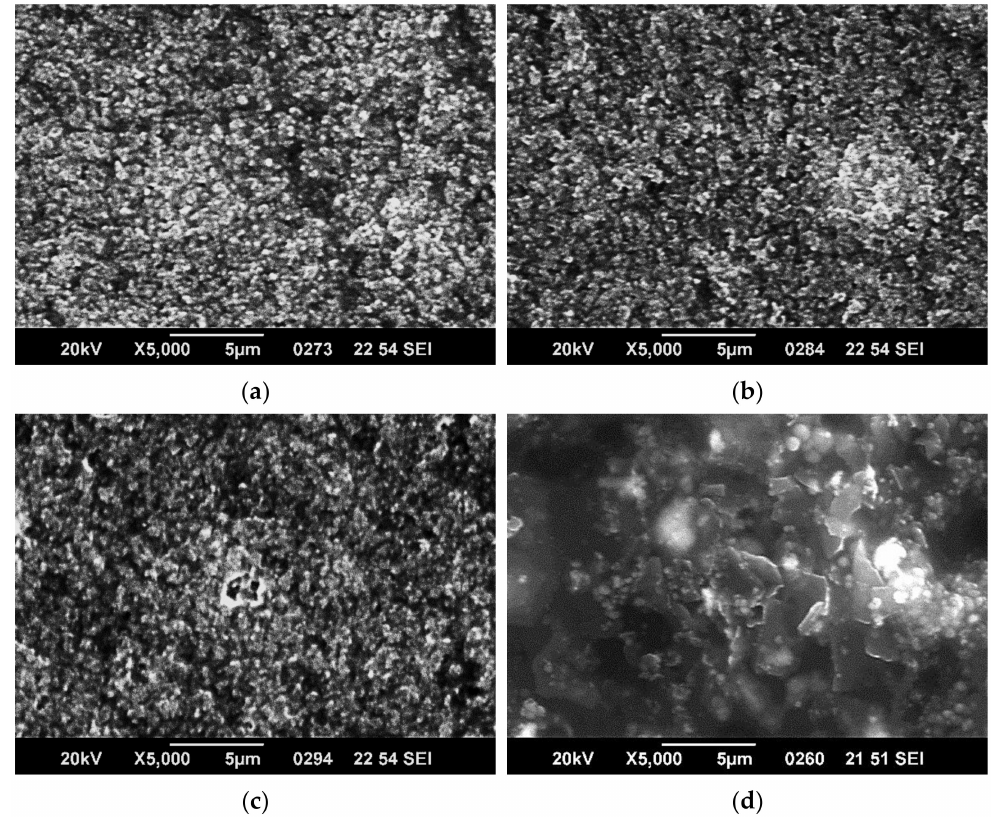
Figure 5. × 5000 magnification SEM images of 3 layers of paint ( a ) 3 layers of B1 paint ( b ) 3 layers of B2 paint ( c ) 3 layers of B3 paint ( d ) 3 layers of V